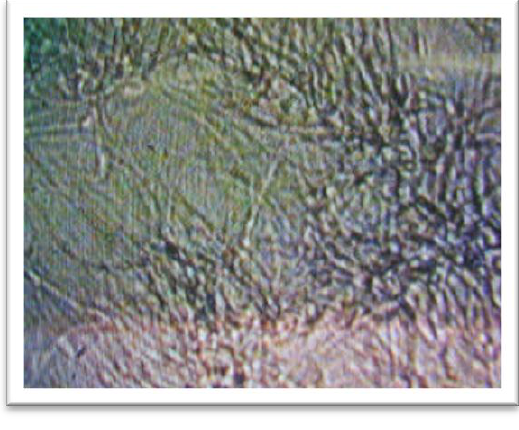
Figure 4 : Mice sperms under